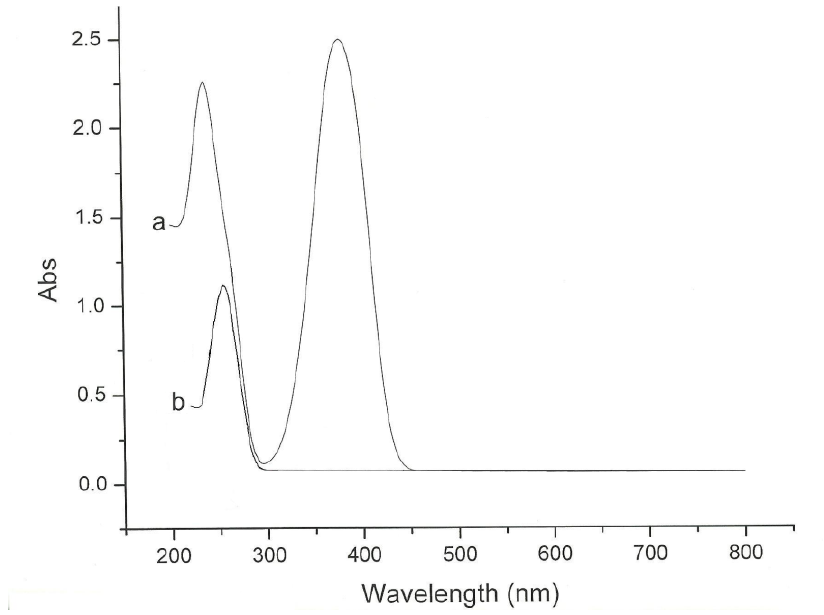
Figure 5 . The Experimental UV-vis of ANP (a) and theoretical (b). Table 6 . The UV-vis excitation energy (∆E) and oscillator strength ( f) for ANP